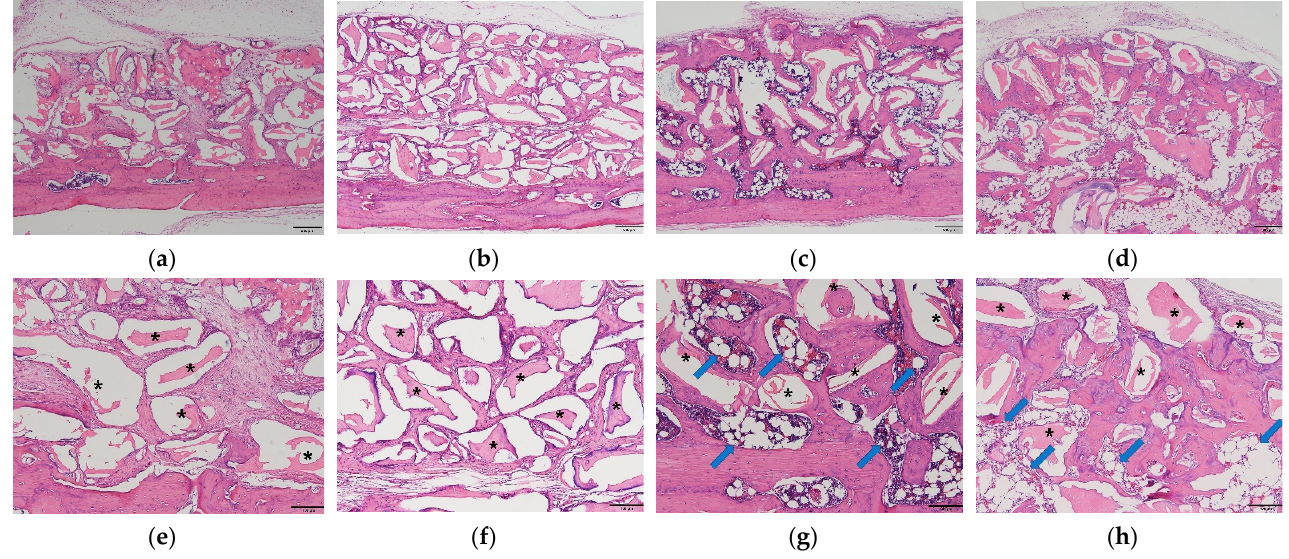
Figure 5. Histologic images (hematoxylin and eosin staining) of each group. ( a , e ) Particle (P), ( b , f ) Block (B), ( c , g ) P+bone morphogenetic protein (BMP), and ( d , h ) B+BMP groups. New bone formation and adipose tissue (blue arrow) were observed in the particle and B+BMP groups. ( e – h ) show high magnification images of ( a – d ), respectively. Black asterisks = bone scaffold (( a – d ), original magnification 40 × , bar = 200 µ m; ( e – h ), original magnification 100 × , bar = 100 µ m).